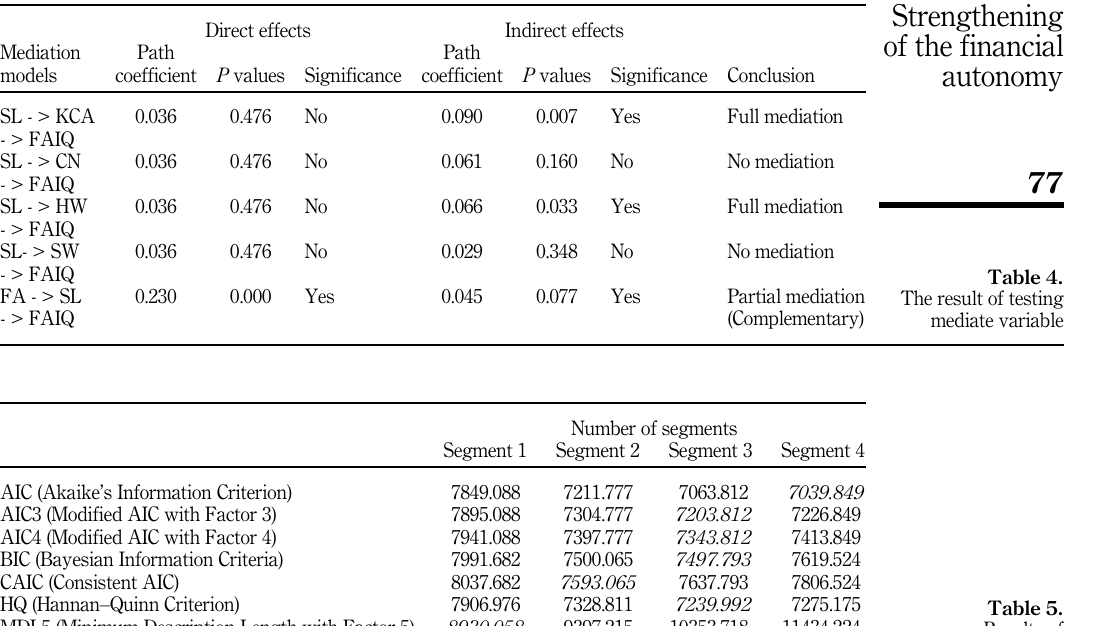
Table 5. Results